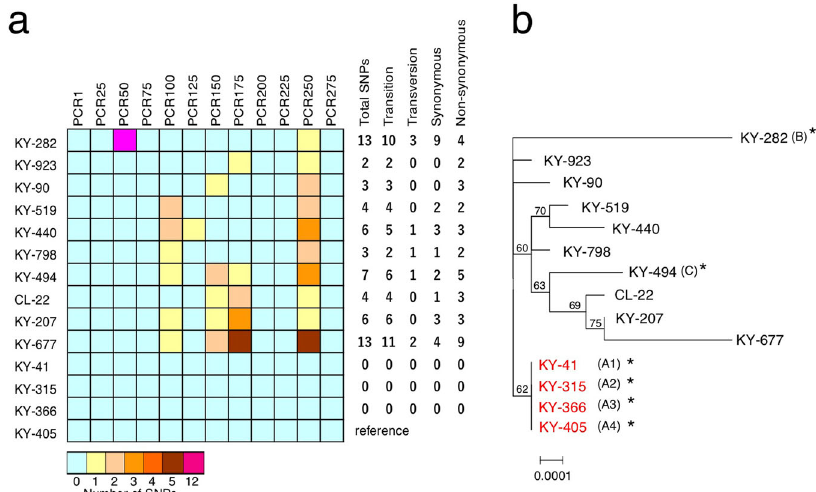
Fig. 6 Genomic diversity of IOLA. a Twelve genomic segments (PCR1 to PCR275; approximately 1 kb in size, located in the IOLA genome at approximately 25-kb intervals) were ampli fi ed by nested PCR from 14 IOLA-positive clinical specimens and sequenced (see Supplementary Data 5 for the genomic positions of each segment). The numbers of SNPs in each segment (reference: KY-405) and the total number of SNPs and proportions of each SNP type are shown on the right-hand side. b An ML tree constructed based on the concatenated sequences of 12 genomic segments (12,410 bp in total). The scale bar indicates substitutions per site. The four specimens indicated in red were obtained from a single